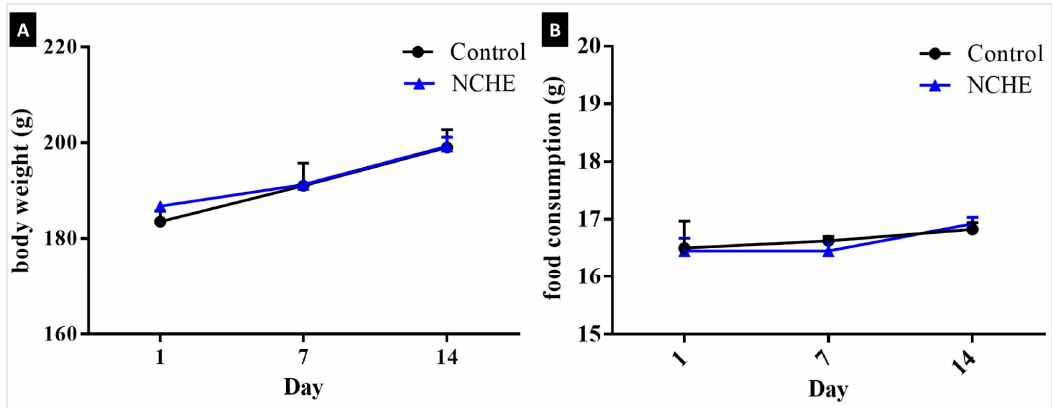
Figure 1. Relative body weight ( A ) and food consumption ( B ) of female rats treated with a single dose (2000 mg/kg) of Nopalea cochenillifera hydroethanolic extract (NCHE) observed for 14 days. Data are expressed as Mean ± SEM ( n = 6/group). No statistical differences were detected between the treated group and the control group.